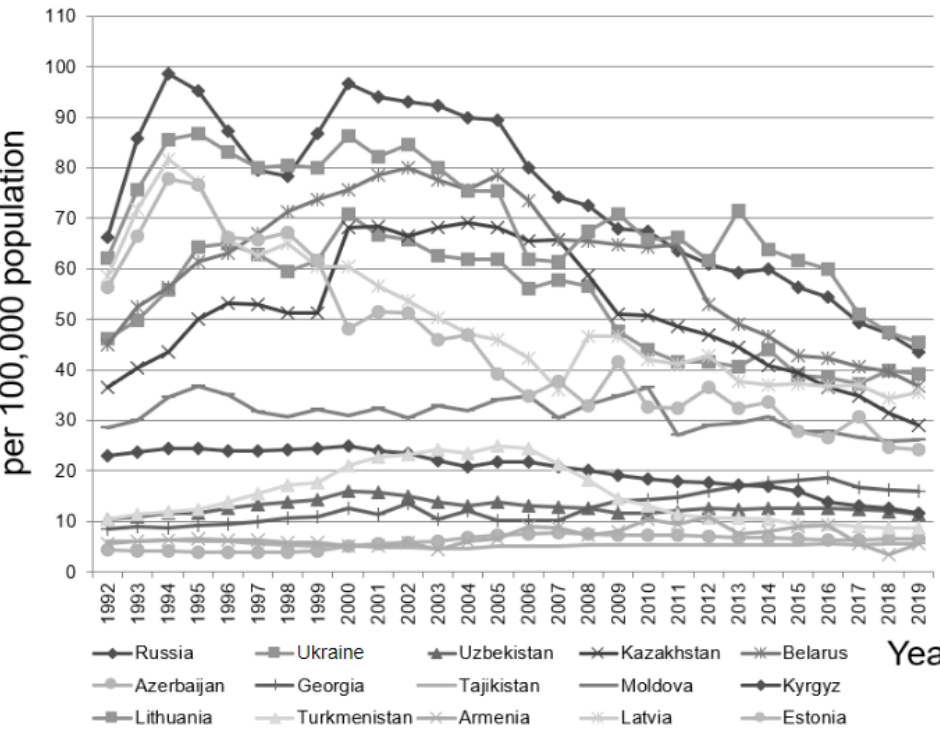
Figure 2. The annual suicide rate among males in the 15 post-Soviet countries in 1992 – 2019.